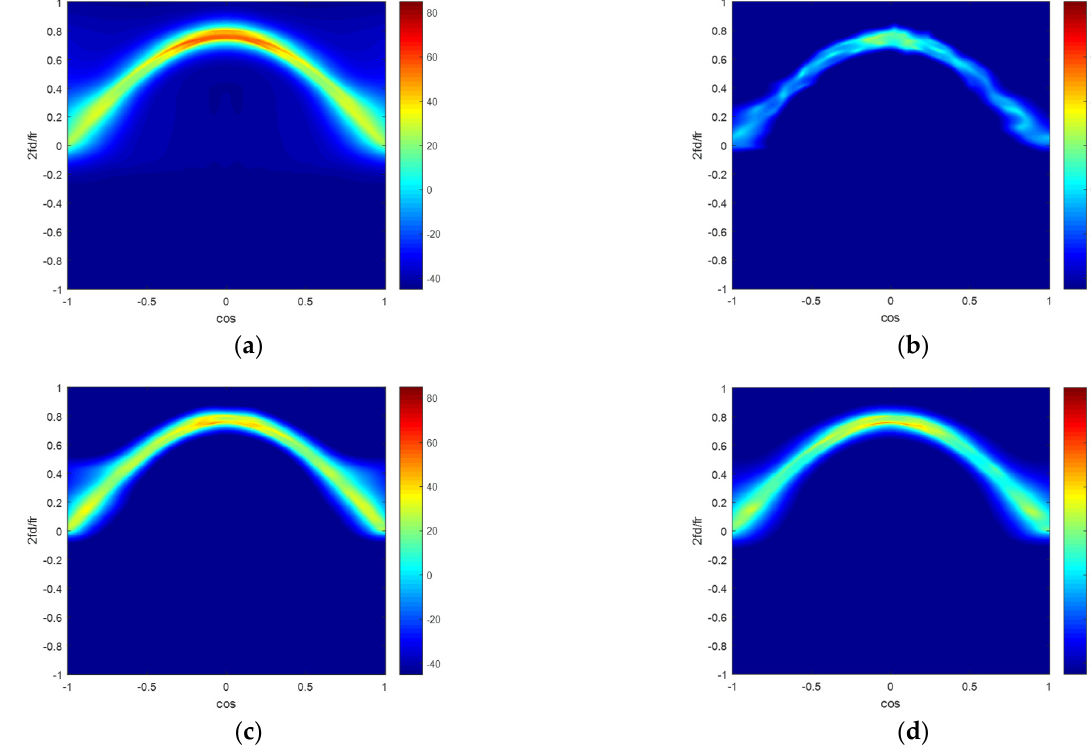
Figure 5. Clutter Angle-Doppler capon spectrums estimated by different methods in the non-ideal condition with model errors: ( a ) ideal CNCM; ( b ) SMI; ( c ) KASPICE-STAP; ( d ) the proposed method.